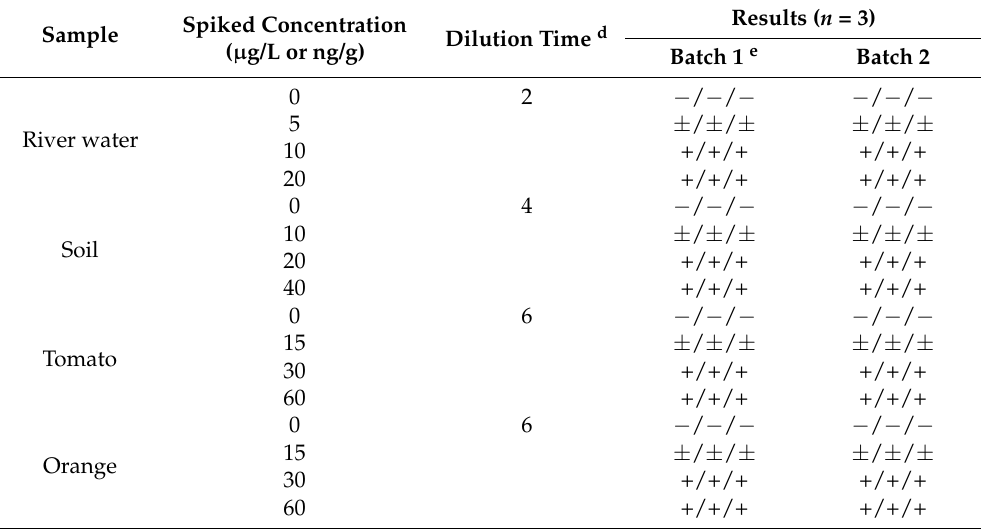
Table 2. Detection of clothianidin in the spiked samples GICA. Visual assessment of the test lines was based on three concentration intervals: negative ( − ), weakly positive ( ± ), and strongly positive (+). Results ( n = 3) Spiked Concentration Sample Dilution Time d ( µ g/L or ng/g) Batch 1 e Batch 2